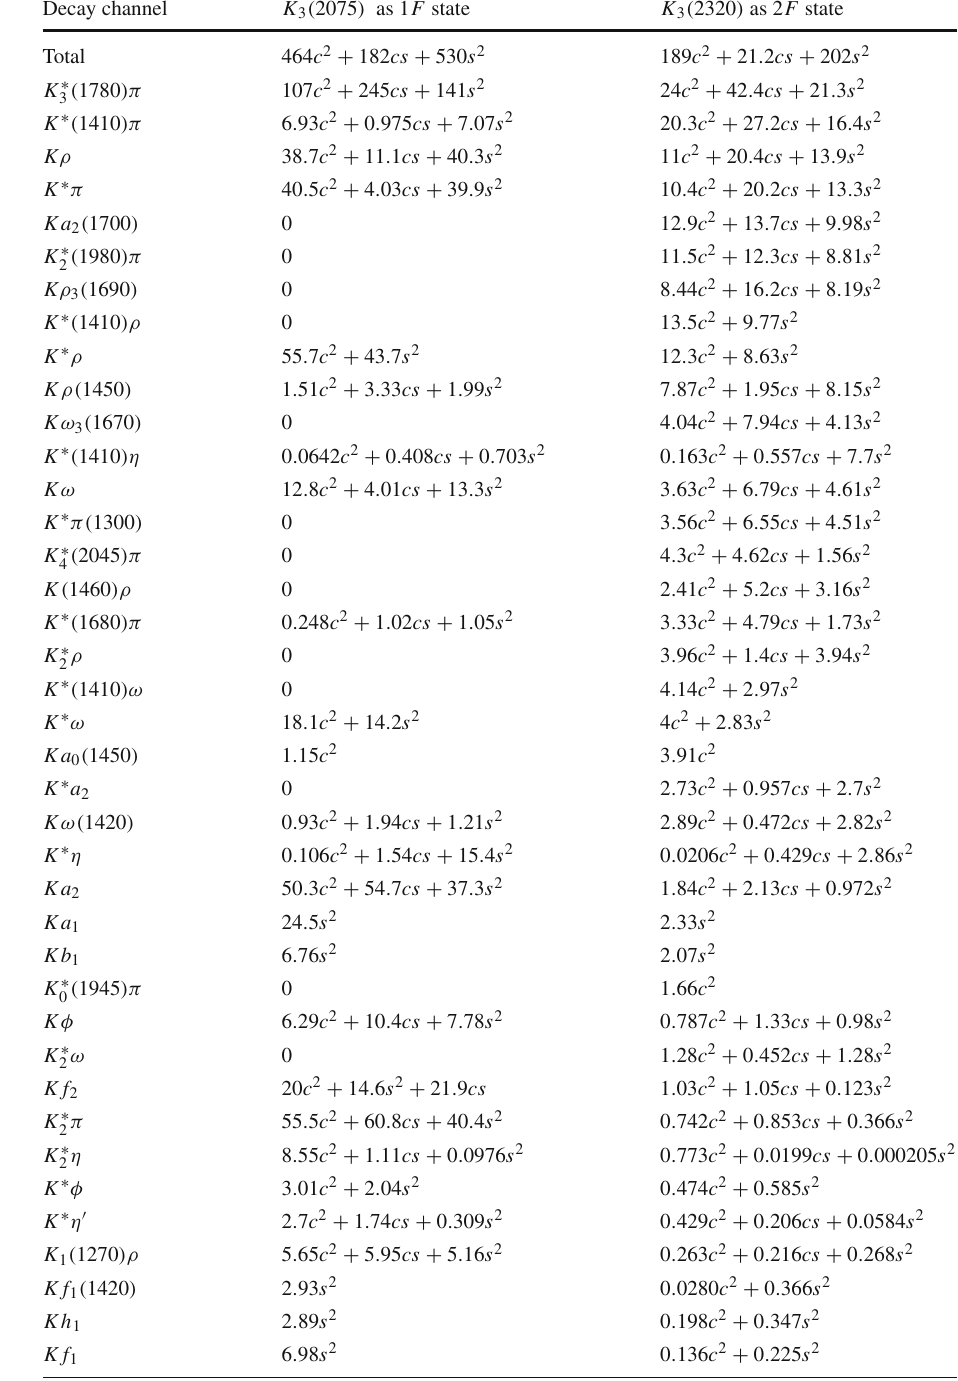
information of K 3 ( 2320 ) as an 2 F state and (predicted) K 3 ( 2075 )( 1 F ) depending on their mixing angle, where s and c represent sine and cosine functions. The unit of the width is